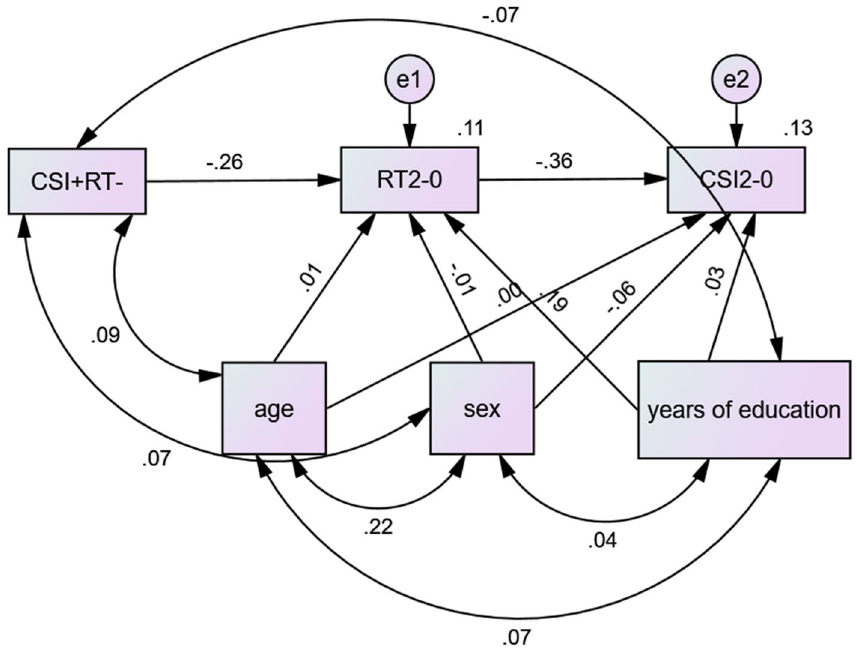
Figure 6. The model of CSI + RT − → RT 2–0 → CSI 2–0 , which showed the best fit of all 12 models, is shown with path coefficients, covariates and covariance structures. Figure was generated by IBM SPSS Amos 22 (https:// www. ibm. com/ suppo rt/ pages/ downl oading- ibm- spss- amos-